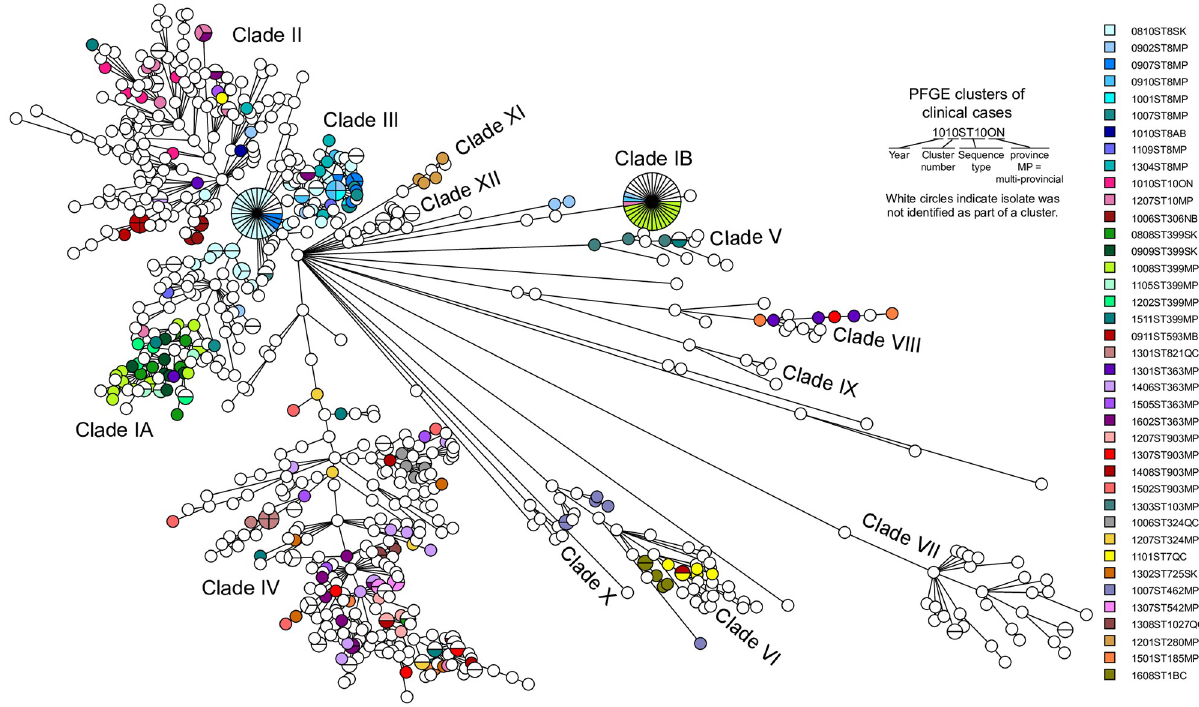
Fig 4. MST showing the distribution of PFGE case clusters. A full wgMLST UPGMA dendrogram (S1 Fig) was used to create this MST.